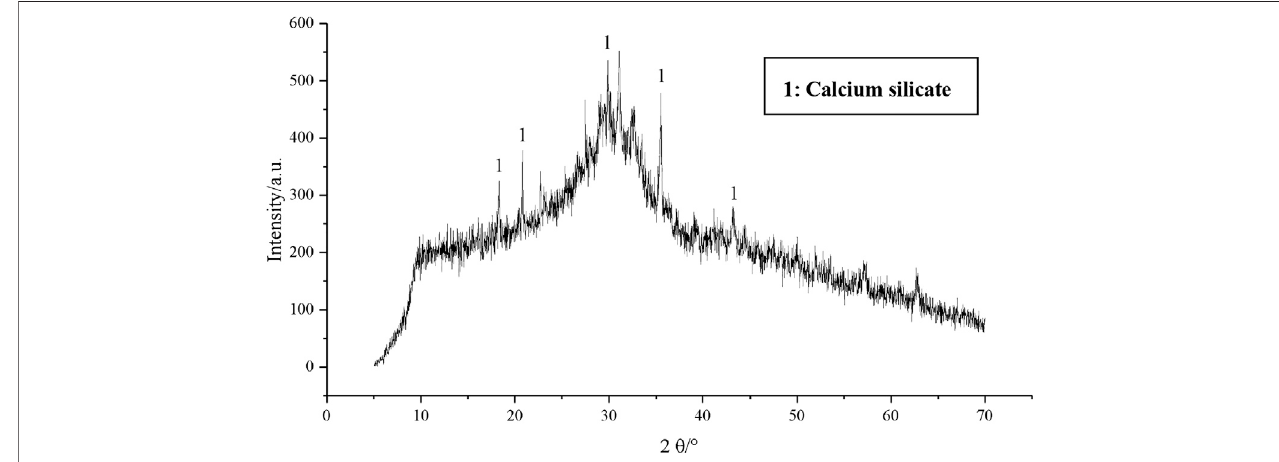
FIGURE 2 | XRD pattern of GGBFS in the current study.